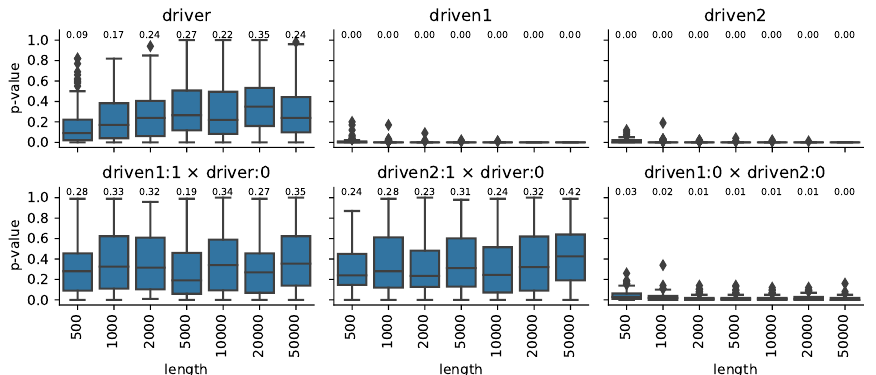
Figure 3. Markov property of coupled logistic systems. The final p -values of the independence test for the single processes in the upper row, for the joint processes in the lower one for different sample sizes. After the colon symbol, the lag is indicated, the symbol stands for the joint of the two series. × The number over the boxes indicates the median value.